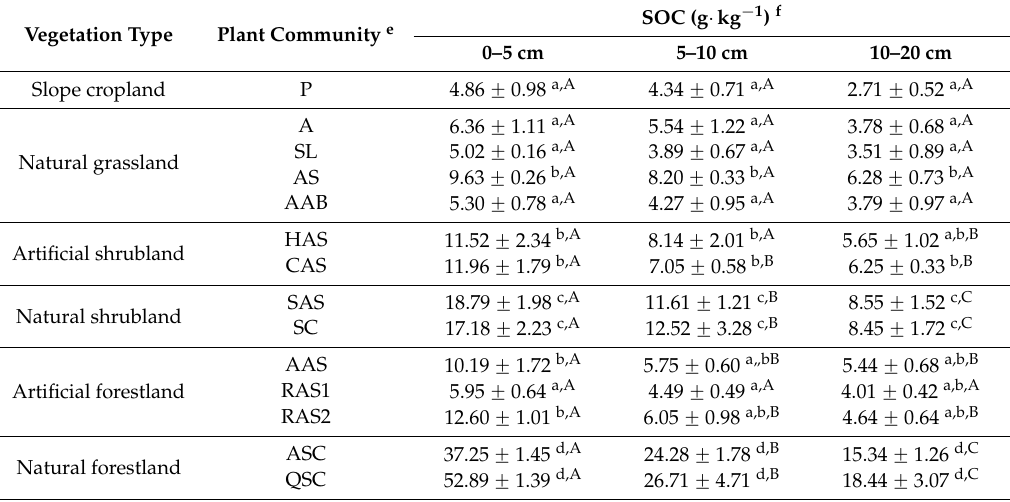
Table 2. Average values and standard deviations of the SOC content of different soil layers under different plant